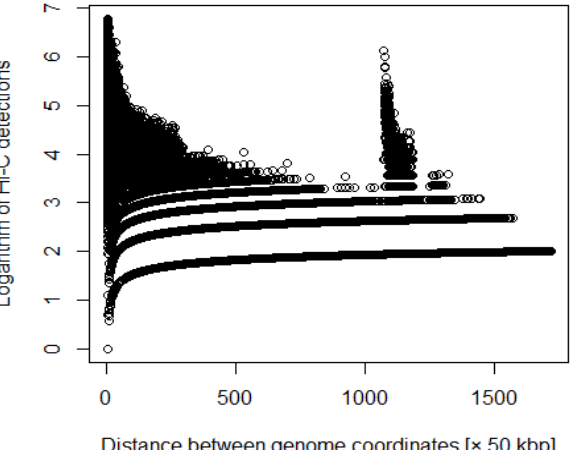
Figure 1. Distance between coordinates versus logarithm of Hi-C detections before adding weighting.